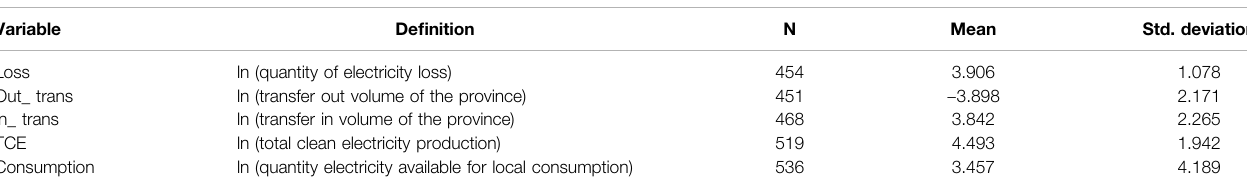
TABLE 5 | Description and de fi nition of relevant variables.